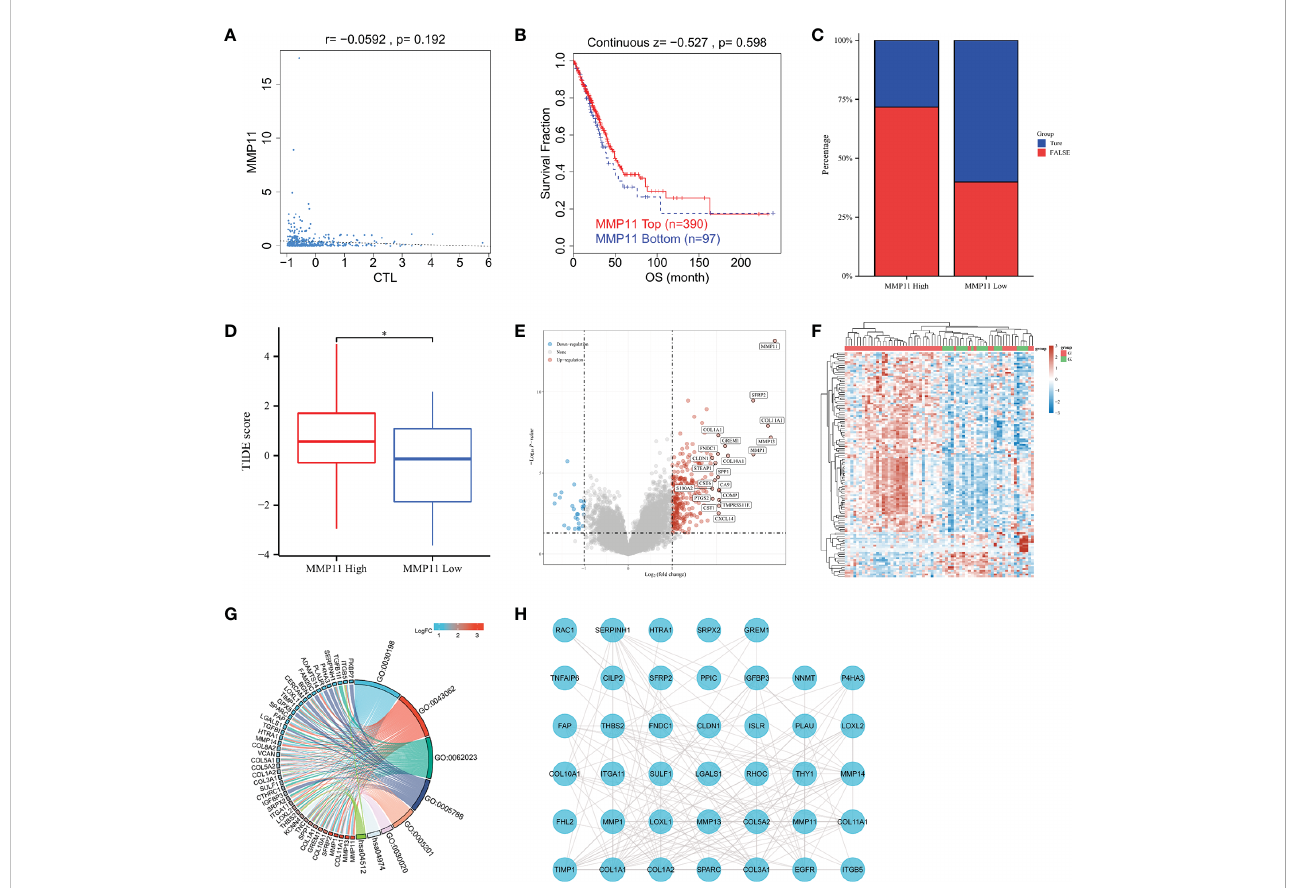
FIGURE 4 Relationship between MMP11 and immune response. (A) Correlation of MMP11 with cytotoxic T-cell level in TCGA-LUAD (TIDE); (B) Kaplan-Meier curves of survival ratios as a measure of the immunotherapeutic response (immune checkpoint blockade) between groups with high and those with low expression levels of MMP11 in TCGA-LUAD (TIDE); (C) Proportions of samples in EGFR mutant lung adenocarcinoma MMP11 high and low expression groups (histogram, TCGA); (D) Difference in TIDE scores between the high MMP11 expression group (red) and low expression group (blue) in EGFR- mutant LUAD (TCGA), *P < 0.05; (E) Differential gene analysis of EGFR-mutant LUAD MMP11 high and low expression groups; blue indicates downregulation; and red indicates upregulation; (F) Correlation heatamap of 50 upregulated genes and 50 downregulated genes; red indicates upregulation; blue indicates downregulation; the darker the color, the higher the correlation; (G) Functional enrichment analysis of the top 100 genes with the most signi fi cantly different trends of alteration; KEGG and GO; (H) PPIs of the 50 genes with the most signi fi cant differences in the EGFR mutant lung adenocarcinoma MMP11 high and low expression groups and